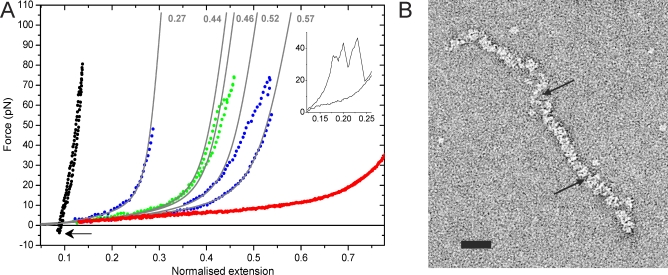
Fully Covered ssDNA-VirE2 Filaments Consist of Stiff Rods(A) Force versus extension curves of fully coated (black), partially coated (blue, green) ssDNA-VirE2 filaments, and uncoated ssDNA (red) in assembly buffer at low protein concentration. Extension curves are normalized to the contour length of ssDNA measured prior to exposure to VirE2. Three typical ssDNA-VirE2 curves were recorded within ∼120 s. Gray lines are extensible FJC fits; the numbers (top) indicate the fraction of uncoated ssDNA. Abrupt jumps in the force-extension curve indicate cooperative release of VirE2 domains (blue curve and sawtooth pattern in inset). Multiple pull-and-release cycles produce a single rigid helical domain (black curve) that resists compression forces of ∼3.5 pN (obtained by reversing the direction of pulling [buckling force, arrow]).(B) ssDNA–VirE2 complexes observed by negative-stain EM showing multiple nucleation sites leading to different VirE2-ssDNA helical domains, which are not in register (arrows indicate the separation between helical domains). Scale bar: 30 nm.